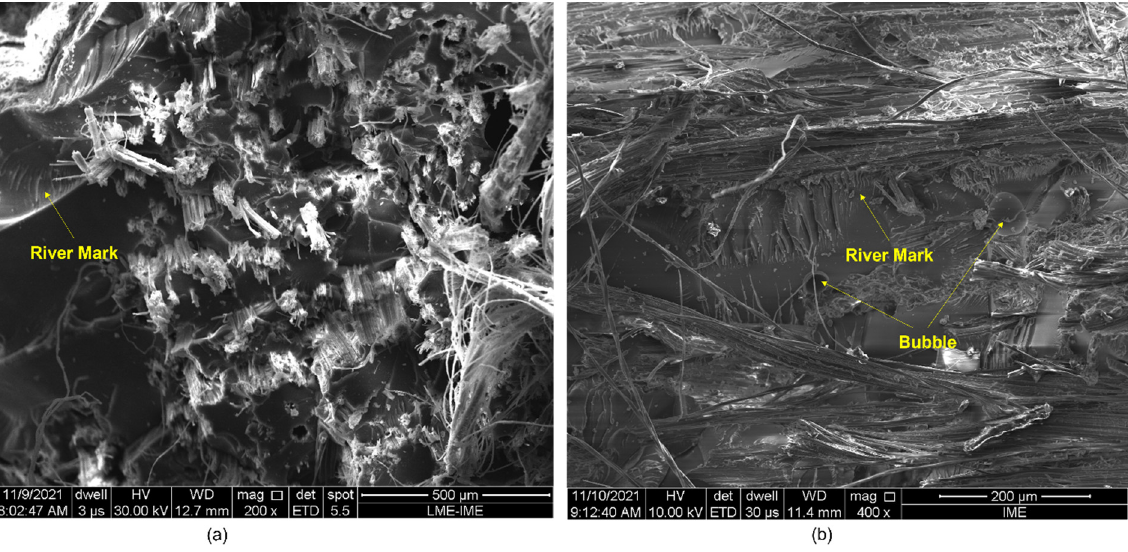
Figure 6. Fracture surface of a composite with 10 vol.% of fibers (PNT/ENT) arranged: unidirection- ally, at 200× magnification ( a ) and bidirectionally, at 400× magnification ( b ).